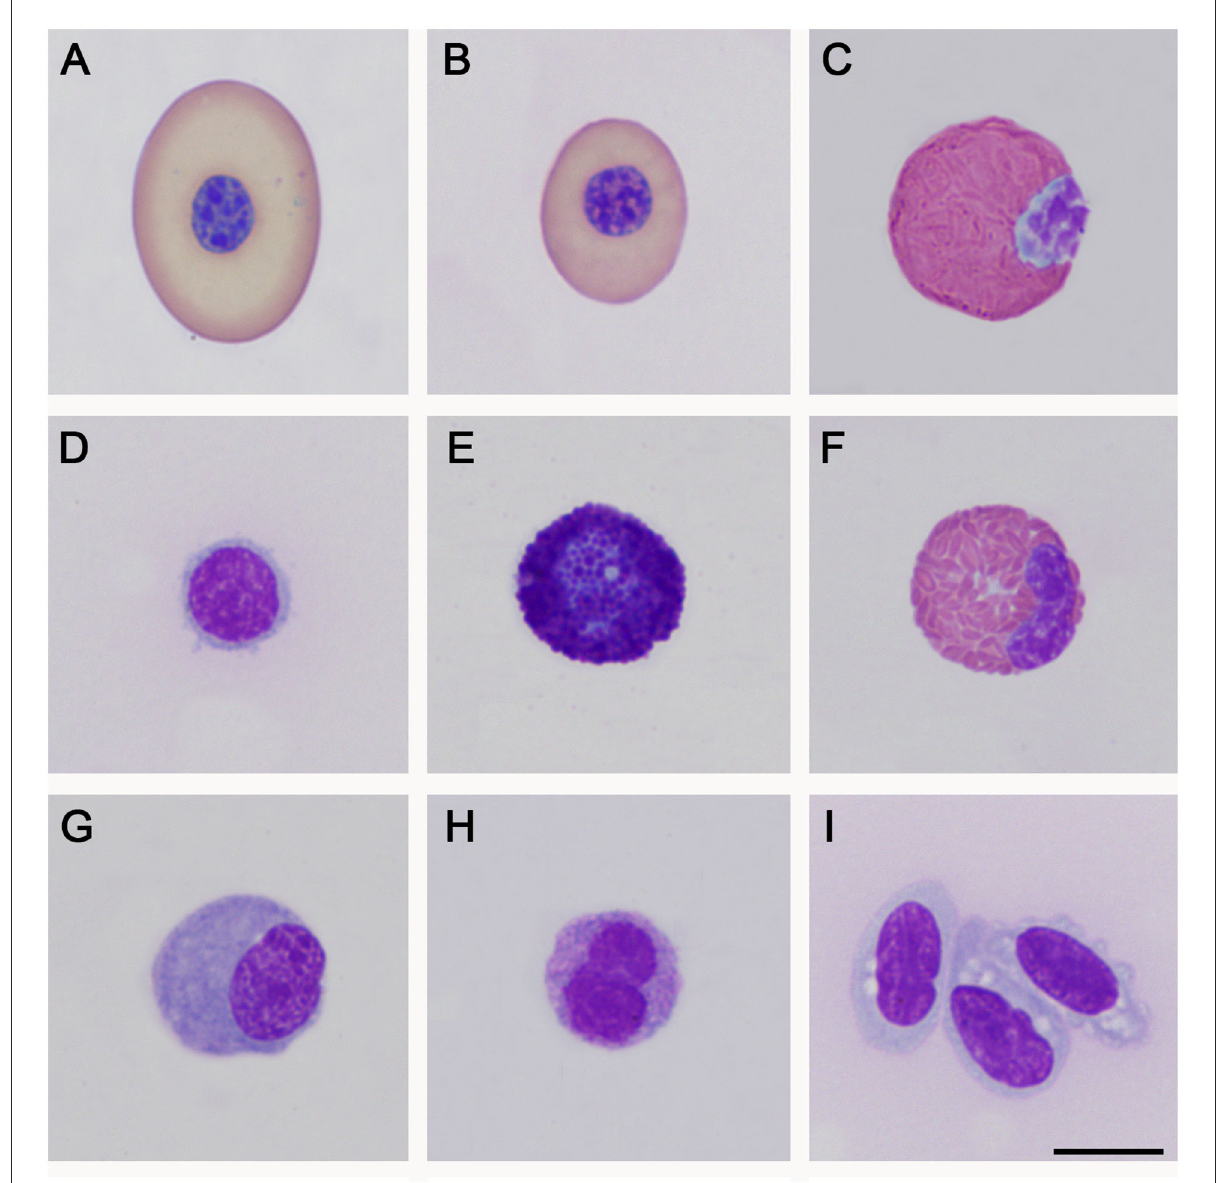
FIGURE1 Peripheral blood cells of Podocnemis vogli . (A) : Mature erythrocyte; (B) : Polychromatophil; (C) : Heterophil; (D) : Immature lymphocyte; (E) : Basophil; (F) : Eosinophil; (G) : Monocyte; (H) : Azurophil-like; (I) : Thrombocyte. Wright staining. Bar: 10 µ m.